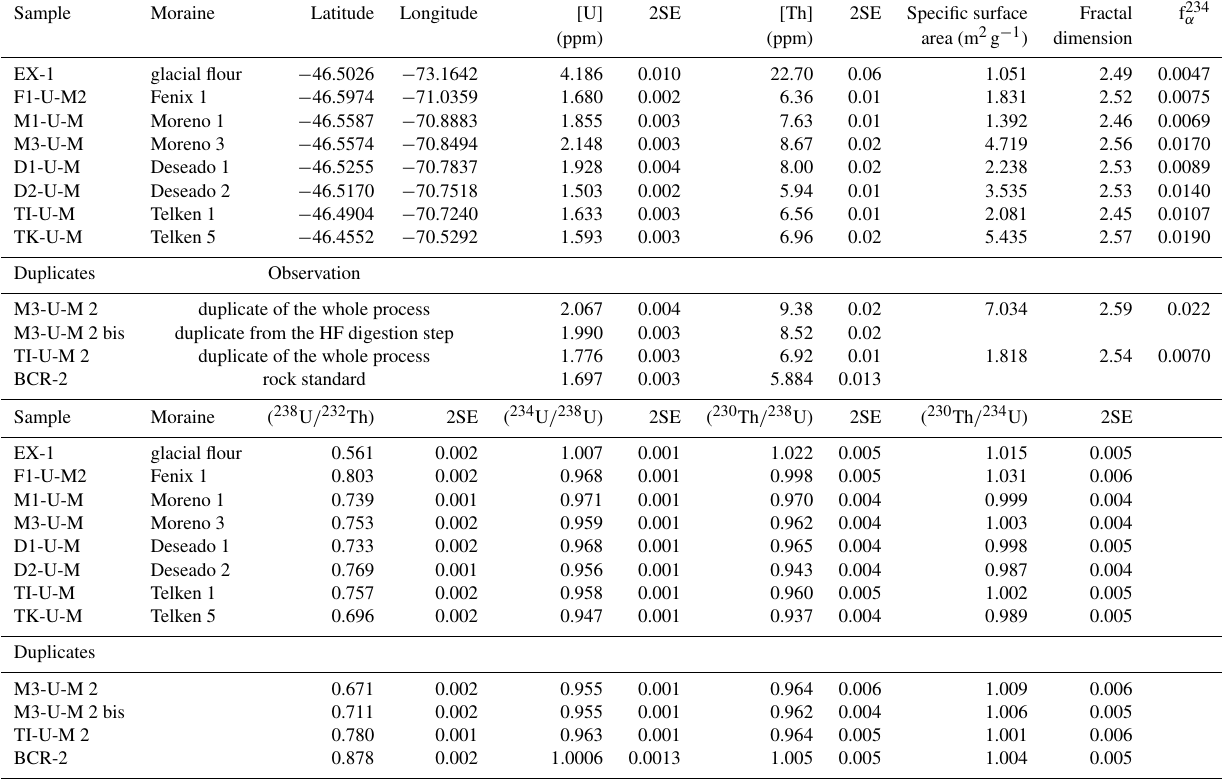
Table 3. U–Th concentrations, activity ratios and BET data (specific surface areas, fractal dimensions and calculated recoil loss factors). Duplicates are also shown, two for the whole process (including sieving, leachings, HF digestion and chromatography) and one for HF digestion and chromatography. The samples are sorted by deposition age (F1: Fenix, M1: Moreno 1, M3: Moreno3, D1: Deseado 1, D2: Deseado 2, TI: Telken 1, TK: Telken